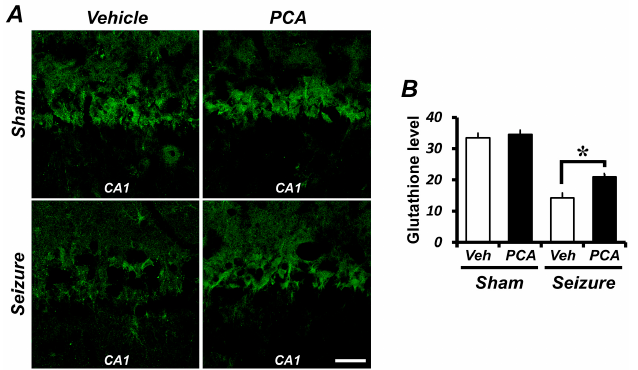
Figure 2. The PCA treatment reverses the glutathione (GSH) level in the hippocampal CA1 pyramidal neuron. ( A ) Confocal images showing glutathione with N -ethylmaleimide (GS-NEM, green) in CA1 pyramidal neurons of the hippocampus. The intensity of GS-NEM is decreased in the seizure-vehicle-treated group when compared to the sham-operated group. The GSH intensity is preserved in the seizure-PCA treated group when compared to the seizure-vehicle group. Scale bar = 100 μ m. ( B ) The bar graph shows the level of neuronal GSH from the individual CA1 pyramidal neurons. Data: mean ± SEM, n = 3 from each group, * p < 0.05.